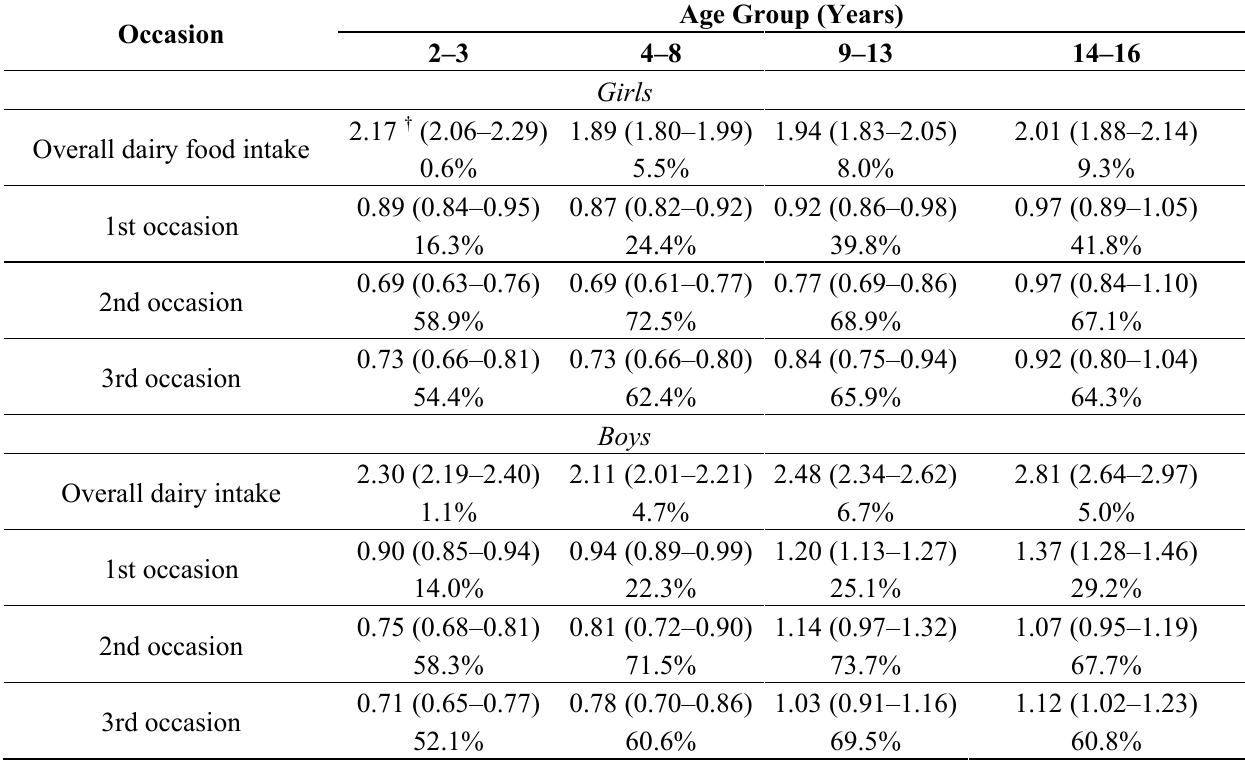
Table 2. Overall mean dairy food intake and mean dairy food intake at each of the first three occasions of eating in consumers grouped by sex and